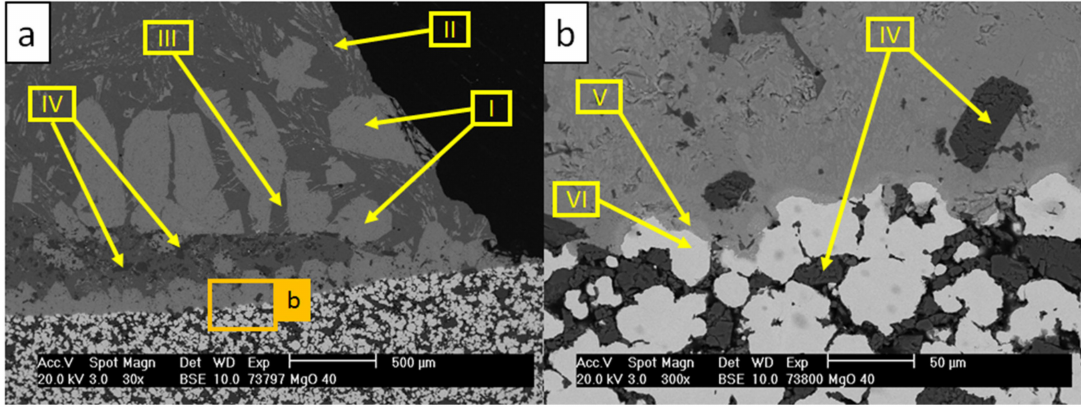
Figure 8. SEM micrographs of the W_0 sample after the corrosion test with AlSi7Mg0.3 at 850 ◦ C: ( a ) image magnified to 30 × ; ( b ) image magnified to 300 ×